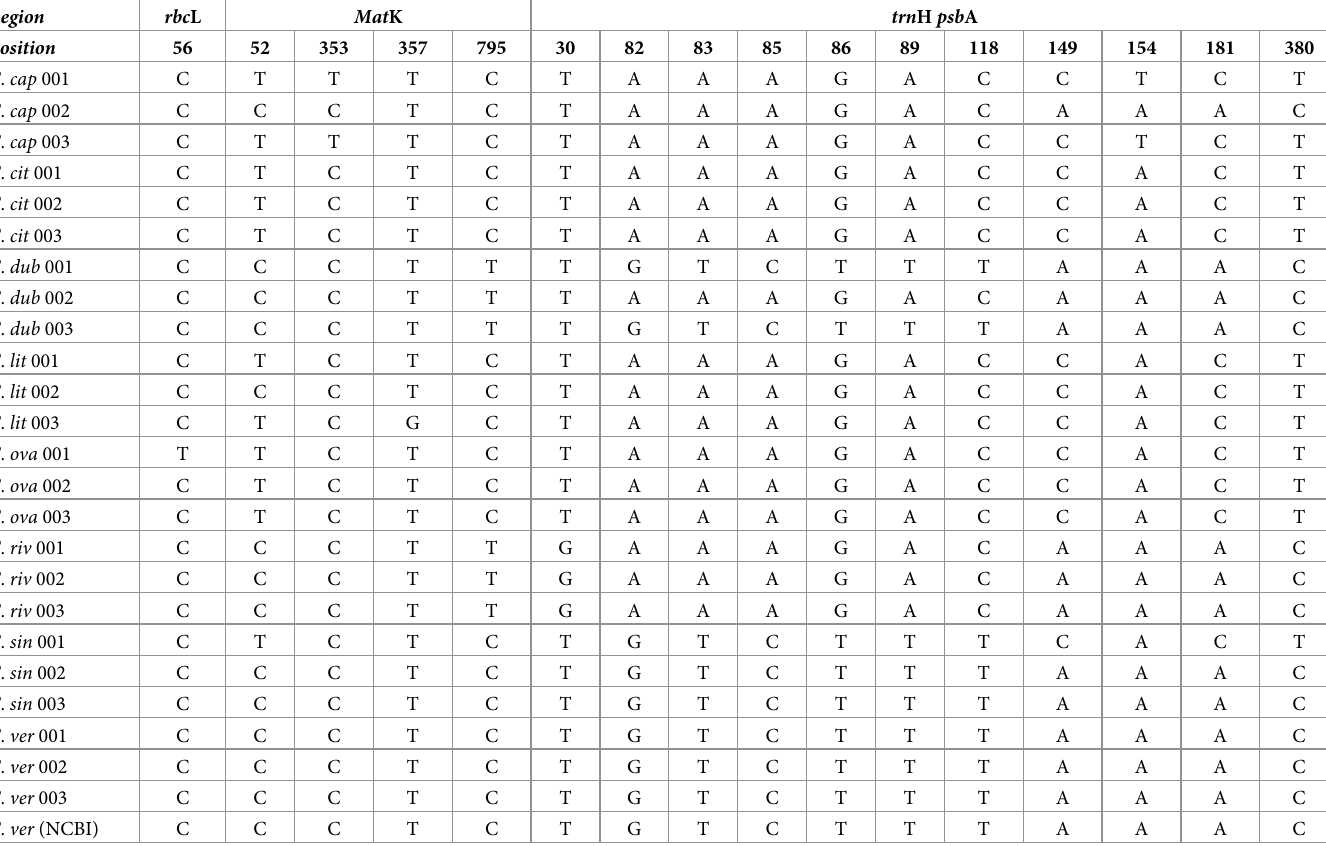
Table 3. Sequence variation of mat K, rbc L, and trn H- psb A regions of Cinnamomum